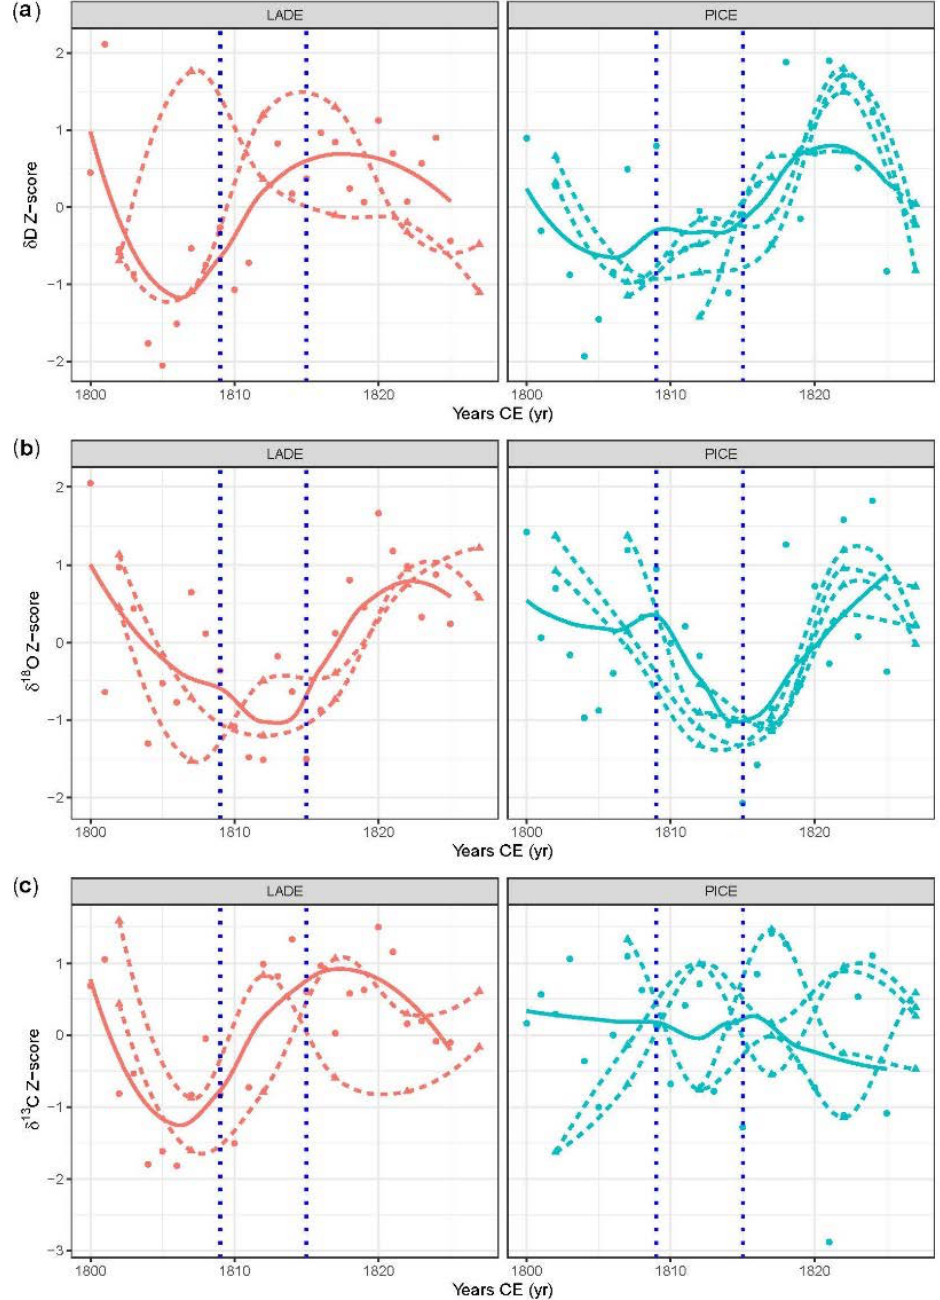
Figure 2. Plots of tree-ring cellulose isotopes for larch (LADE, red lines) and cembran pine (PICE, blue lines) at the time of the Tambora eruption; the points are the individual measurements, and the lines are the spline of each tree. Isotope series with annual resolution are shown with continuous lines, while the 5-year resolution series are given by dotted lines. The vertical dotted lines indicate the time of the Tambora eruption in 1815 CE and of an unidentified eruption occurring in 1809. Panel ( a ): δ D values. Panel ( b ): δ 18 O values. Panel ( c ): δ 13 C values.